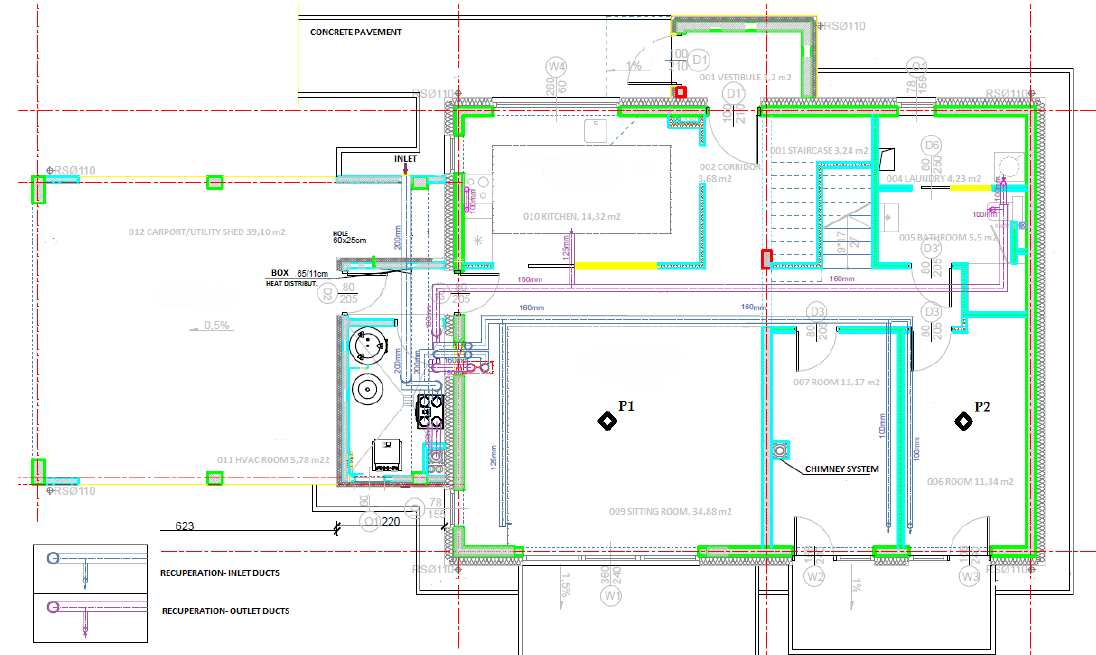
Figure 4. The view of the ground floor of the building with marked measuring points P1 and P2 (black dots) and the layout of the ventilation system with the distinction of inlet and outlet points.